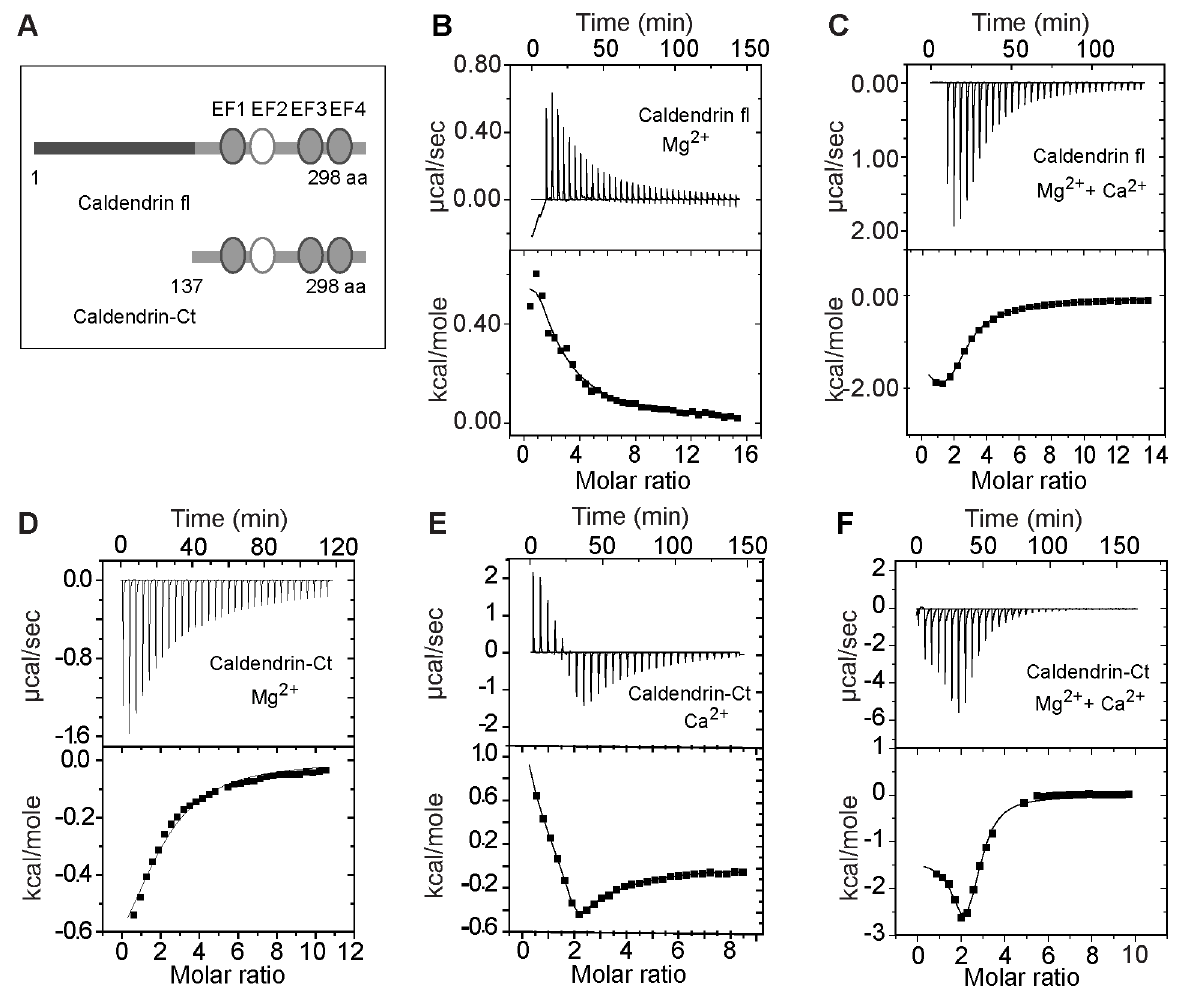
Figure 5. ITC analysis of Caldendrin and the common C-terminus of Caldendrin, L- and S-CaBP1. (A) Cartoon showing the Caldendrin (CDD) full length (1–298 residues) and Caldendrin Ct (137–298 residues) proteins used for ITC. (B) ITC of Apo-Caldendrin with Mg 2 + . Titration was carried out with 10 mM MgCl 2 . Protein concentration was 43 m M. Data were fitted using a sequential binding model. (C) Ca 2 + titration to Mg 2 + saturated Caldendrin. Titration was carried out with 10 mM CaCl 2. Data were fitted using a sequential binding model. (D–F) ITC analysis of Mg 2 + , Ca 2 + and Ca 2 + titration to the Mg 2 + bound common C-terminus of Caldendrin/CaBP1 (173 m M). The upper part in each in each panel shows the traces of calorimetric ion titration and the lower panel represents the integrated binding isotherms obtained from various best fit models. This figure is connected to Table 1 which includes the corresponding ITC values. doi:10.1371/journal.pone.0103186.g005 rescence spectroscopy. We saw that the overall changes in the EF-hand Ca 2 + sensors like Toponin-C and CaM undergo a spectra due to Mg 2 + /Ca 2 + binding to Caldendrin and myristoy- close to open conformational change upon Ca 2 + binding that lated L-CaBP1 were negligible (Figure 2A + B). However, we exposes a hydrophobic surface which then can act as an interface observed a robust change in surface hydrophobicity in Mg 2 + - for target recognition. Accordingly a close to open conformational change upon Ca 2 + binding was observed in the NMR and crystal bound S-CaBP1 (Figure 2C).